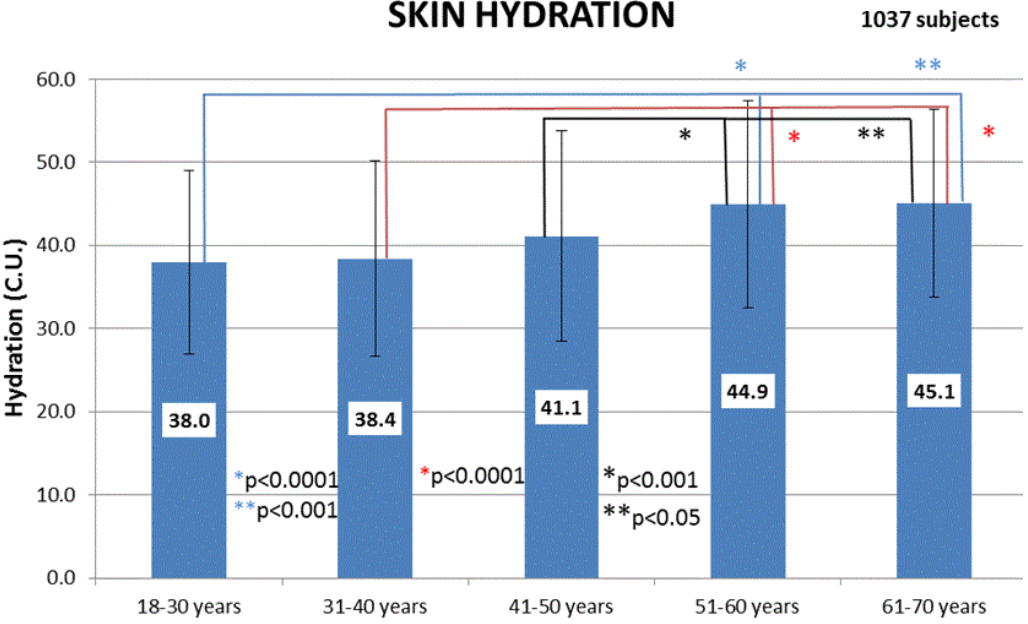
Figure 1. Skin hydration basal values as a function of the age group. Statistical comparison among the age groups: * p < 0.0001 (18–30 vs. 51–60 years); ** p < 0.001 (18–30